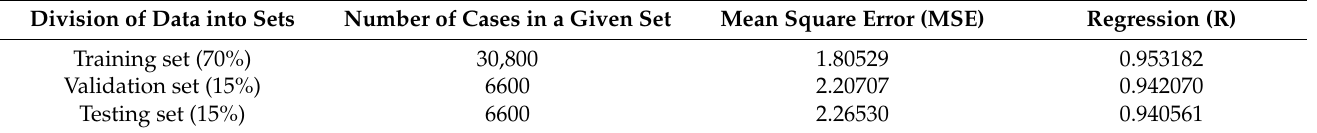
Table 3. The results of the learning process along with the division of data into